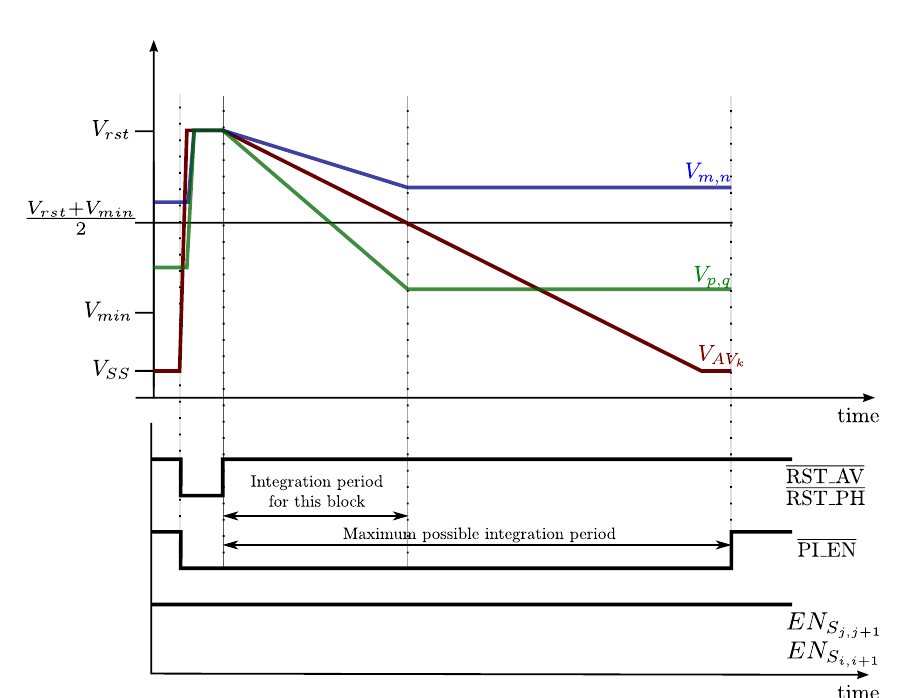
Figure 9. Timing diagram illustrating the operation of block-wise HDR. The dynamics of two pixels belonging to the same block along with the corresponding local averaging voltage is